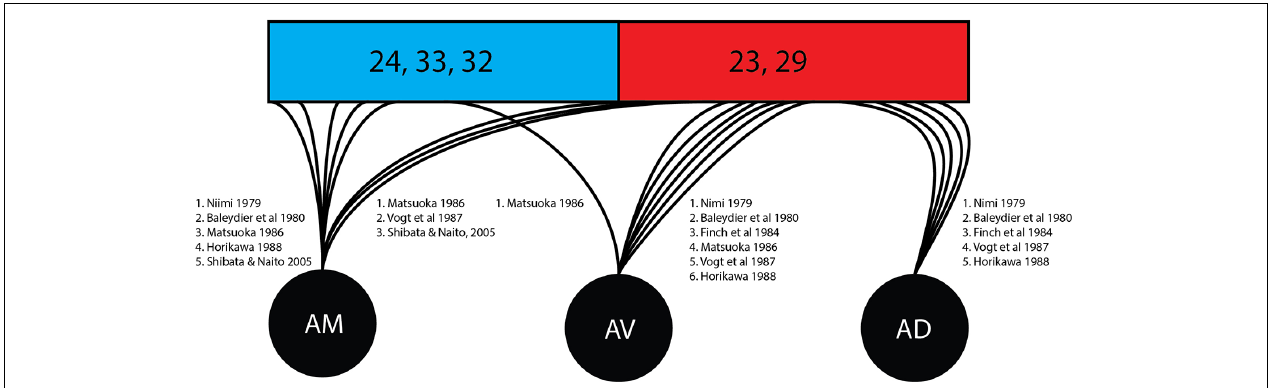
FIGURE 4 | Cingular connectivity of individual thalamic nuclei. Represented is an overview of the quantity of studies tracking the terminations of individual thalamic nuclei once enclose within the cingulate cortex. Brodmann area (BA) 24, 33, and 32 (shown in blue) correspond to the anterior cingulate cortex. Brodmann area (23 and 29 (shown in red) correspond to the posterior cingulate cortex and retrosplenial cortex. AD, anterodorsal nucleus; AM, anteromedial nucleus; ATN, anterior thalamic nucleus; AV, anteroventral